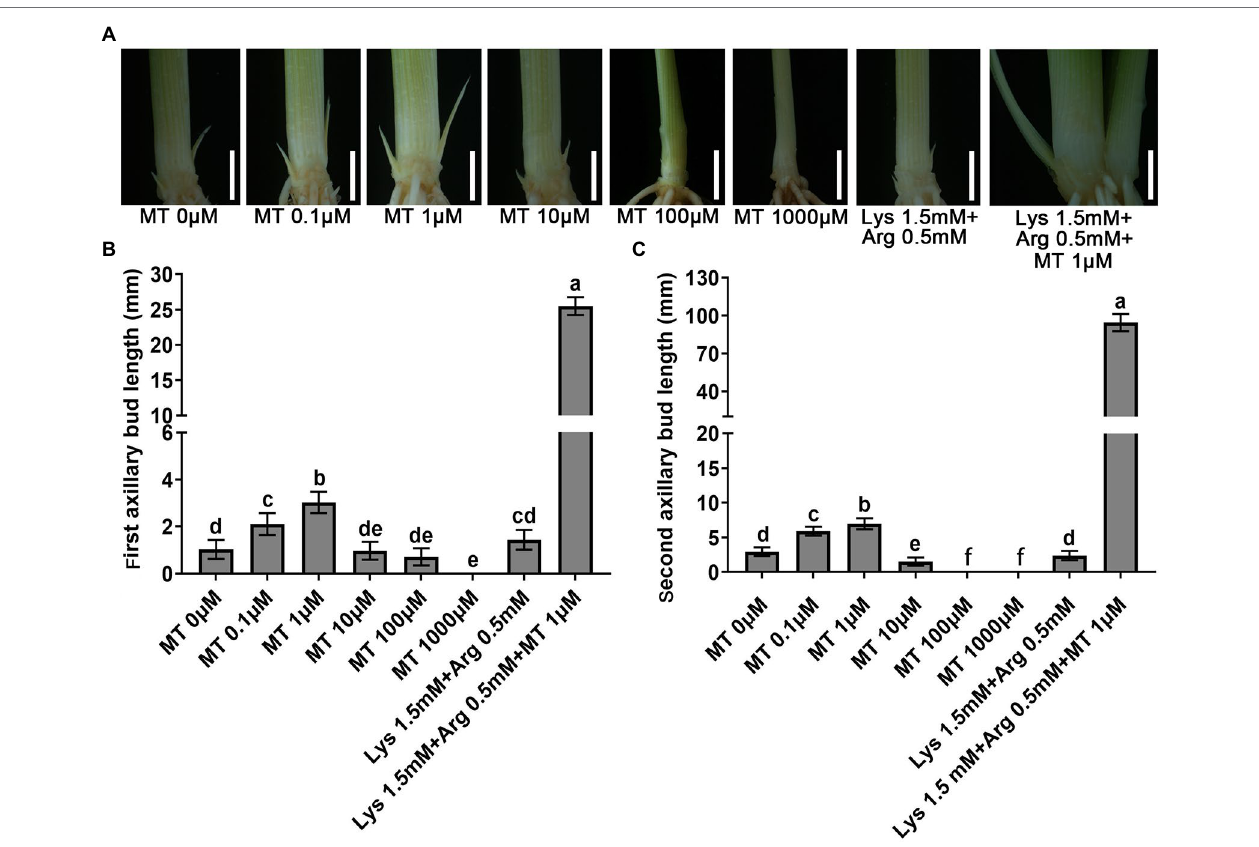
FIGURE 1 | Phenotypes of outgrowth axillary bud under different concentrations of melatonin and amino acids treatments. (A) Phenotypes of outgrowth axillary buds under basic nutrient solutions supplemented with different concentrations of melatonin (0 μ m, 0.1 μ m, 1 μ m, 10 μ m, 100 μ m, and 1,000 μ m), 1.5 mm Lys + 0.5 mm Arg, or 1.5 mM Lys + 0.5 mM Arg + 1 μ m melatonin. Statistical analysis of the first (B) and second (C) axillary bud length in (A) . MT represents melatonin, Lys represents lysine, and Arg represents arginine. Values are means ± SD ( n > 20), and the significance levels of different lowercase letters were as follows, p < 0.05. Scale bar = 3